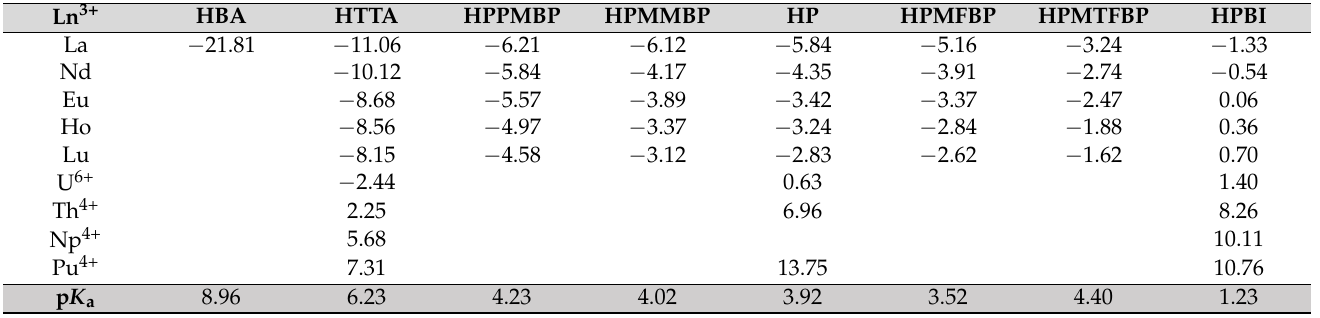
Table 2. Log K values of f-ions using different chelating agents, µ = 0.1/Cl − medium/CHCl 3